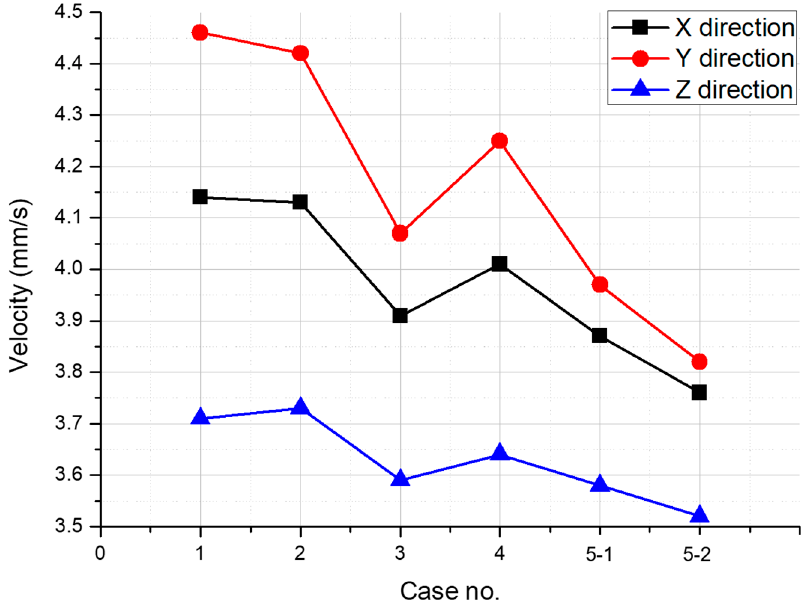
Figure 14. Vibration data by axial direction.